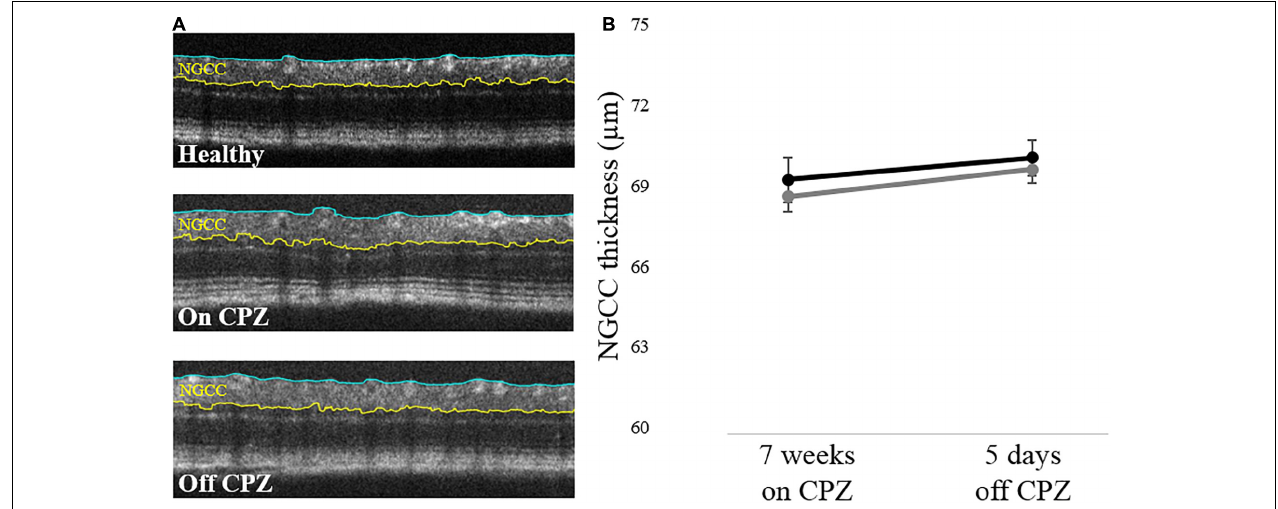
FIGURE 3 | Retinal NGCC thickness of the mice with on and off CPZ diet. (A) Representative OCT segmentation results in Healthy, on CPZ and off CPZ mice. The thickness of NGCC was calculated as the distance between ILM (blue line) and the upper border of INL (yellow line). (B) The black line represents Healthy mice ( n = 12 eyes), the dark gray line represents CPZ mice ( n = 16 eyes). The error bars represent the SEM. Two-way mixed ANOVA showed no significant difference in the NGCC thickness between